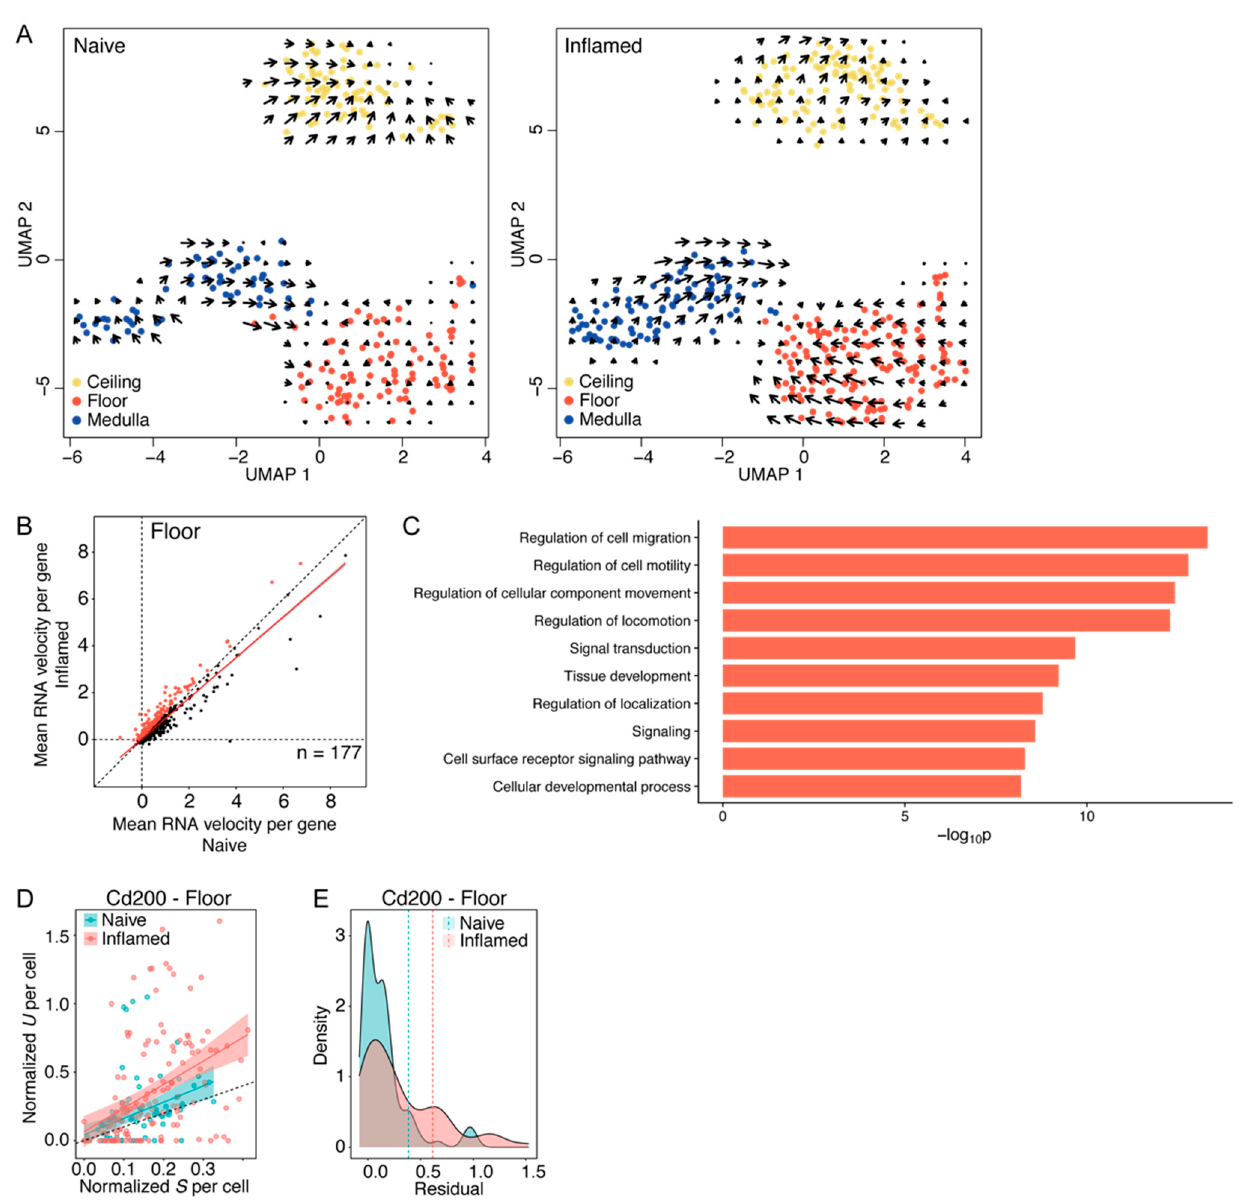
Figure 3. Prediction of future cell states by RNA velocity. ( A ) RNA trajectory of each cell in naïve and inflamed conditions as estimated by Velocyto. ( B ) Correlation of the mean RNA velocity per gene in the floor in inflamed vs. naïve condition. Linear regression is shown in red and the dashed line indicates slope = 1. Selected differentially “speeded” (DS) genes (perpendicular distance to slope = 1 > 0.1) are marked in red. ( C ) Top 10 GO terms of biological processes enriched for DS genes in floor LECs ( p < 0.5, ranked by p values). ( D ) Correlation of spliced (S) and unspliced (U) Cd200 per cell. Linear regressions for naïve and inflamed conditions are shown in blue and red, respectively. The dashed line indicates slope = 1. ( E ) Deviation of the observed abundance of unspliced Cd200 from the expected value (residual) in naïve and inflamed conditions, with positive values indicating an expected up-regulation. The dashed lines show the mean per